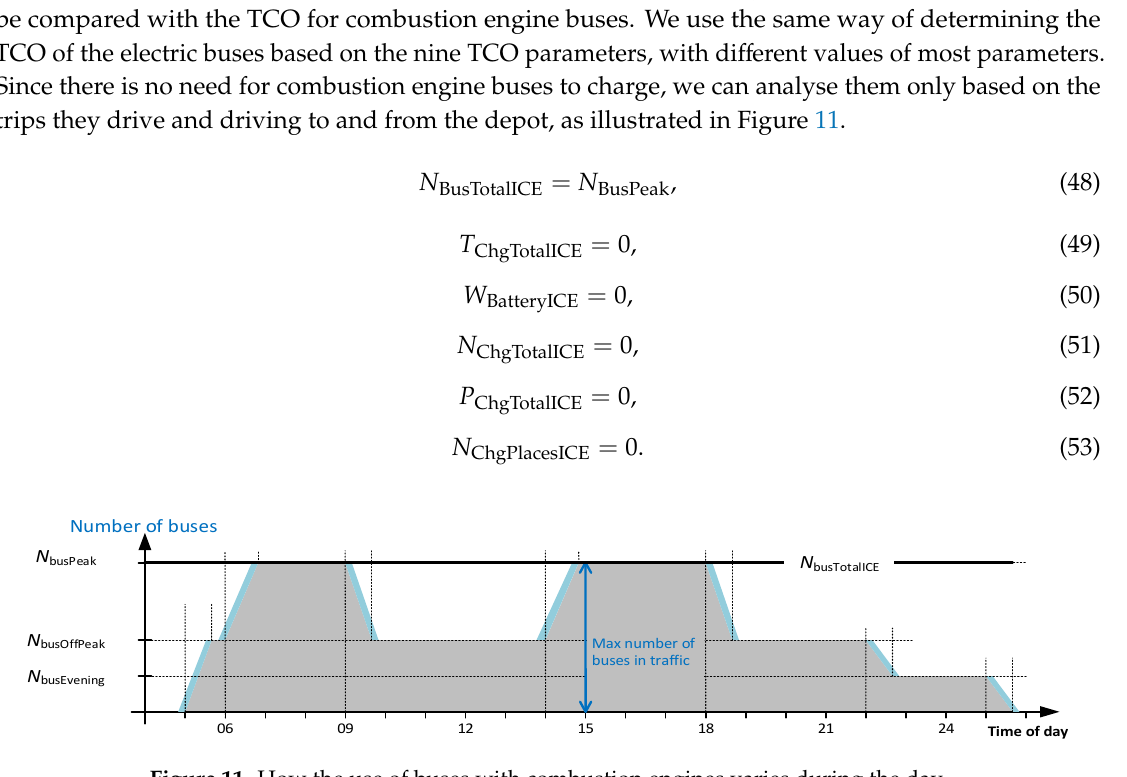
Figure 11. How the use of buses with combustion engines varies during the day.